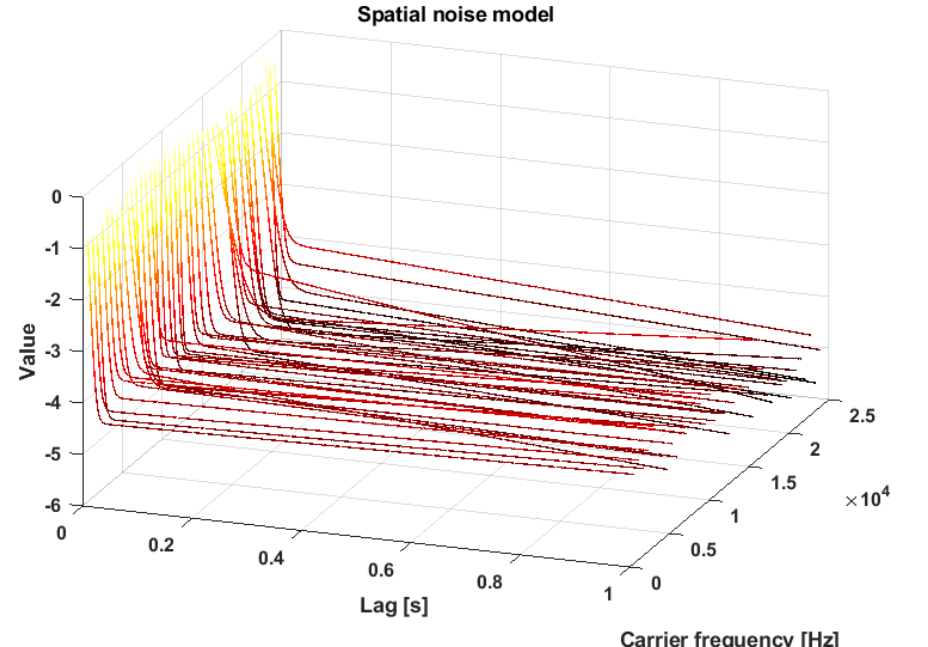
Figure 14. Spatial noise